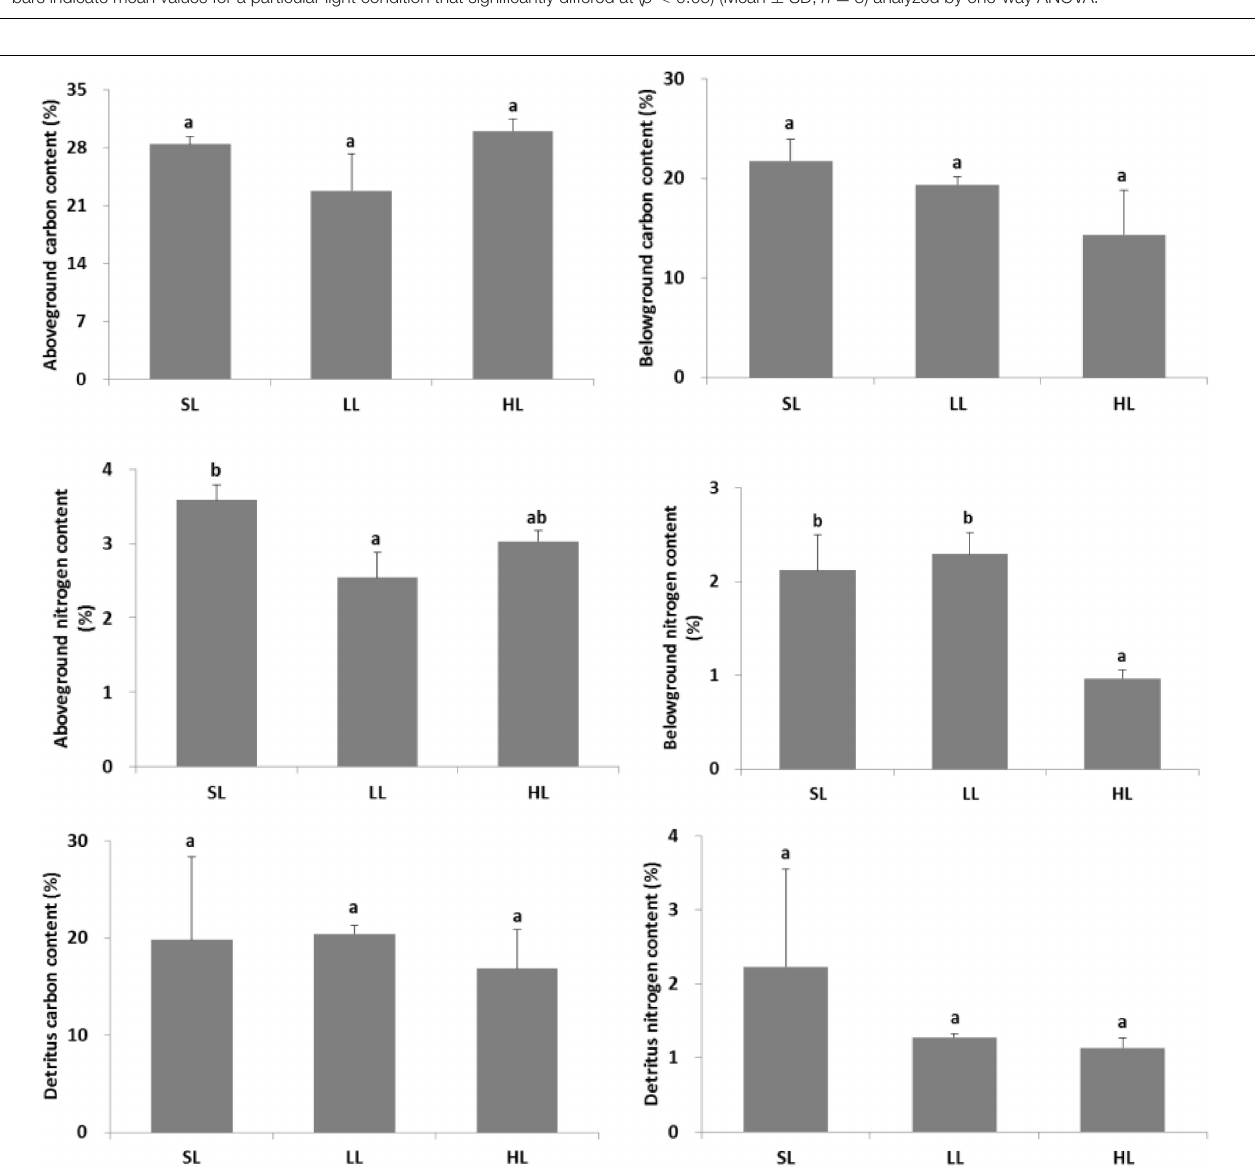
FIGURE 5 | Response of seagrass nutrients to light treatments. Saturating light: SL, 200 µ mol photons/m 2 /s; low light: LL, 20 µ mol photons/m 2 /s; high light: HL, 600 µ mol photons/m 2 /s. SL and HL were in the optimal light range between the minimum saturating light and the minimum inhibiting light. Different letters on the bars indicate mean values for a particular light condition that significantly differed at ( p < 0.05) (Mean ± SD, n = 3) analyzed by one-way ANOVA.